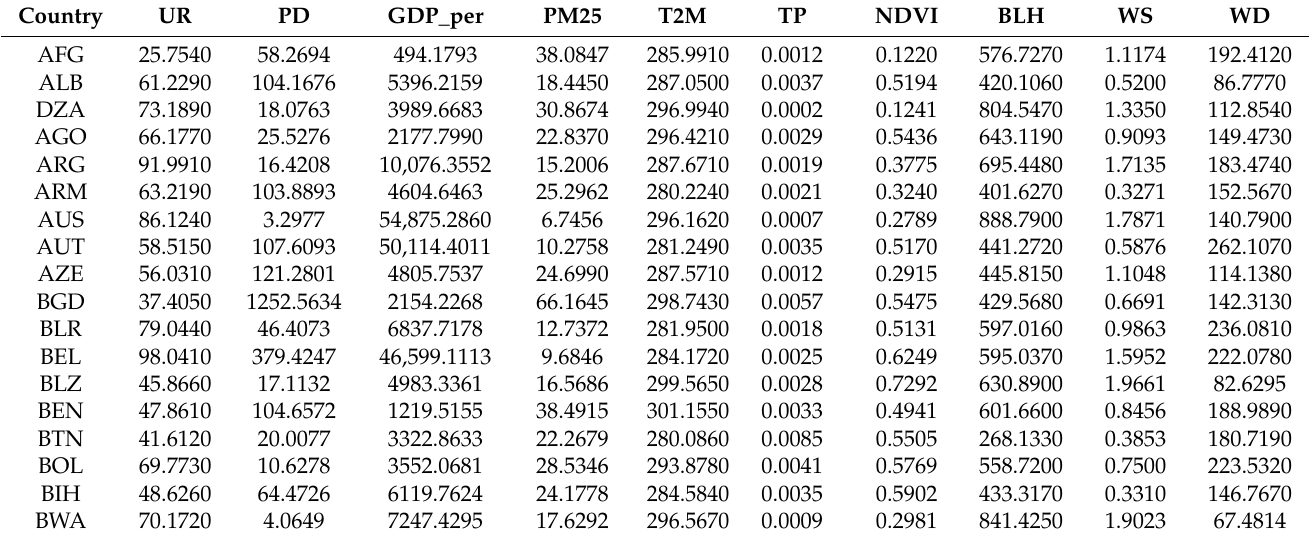
Table A3. Year-wise mean value of all the parameters in